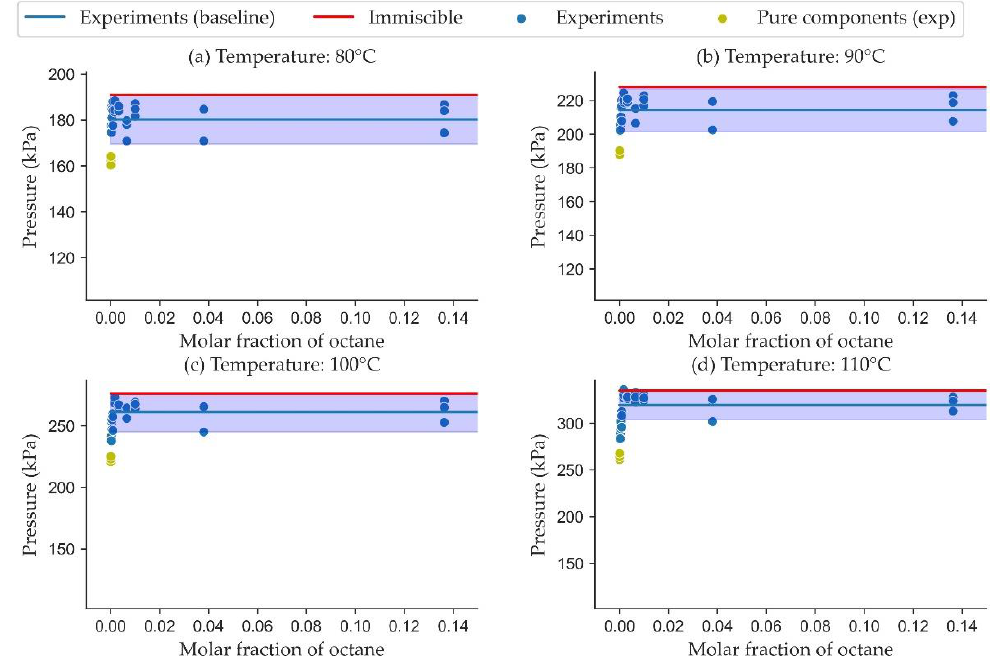
Figure A2. P mix for Highly Diluted Octane in Water Mixtures at 80 °C, 90 °C, 100 °C, 110 °C.